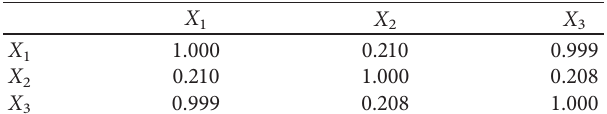
Table 12: Correlation